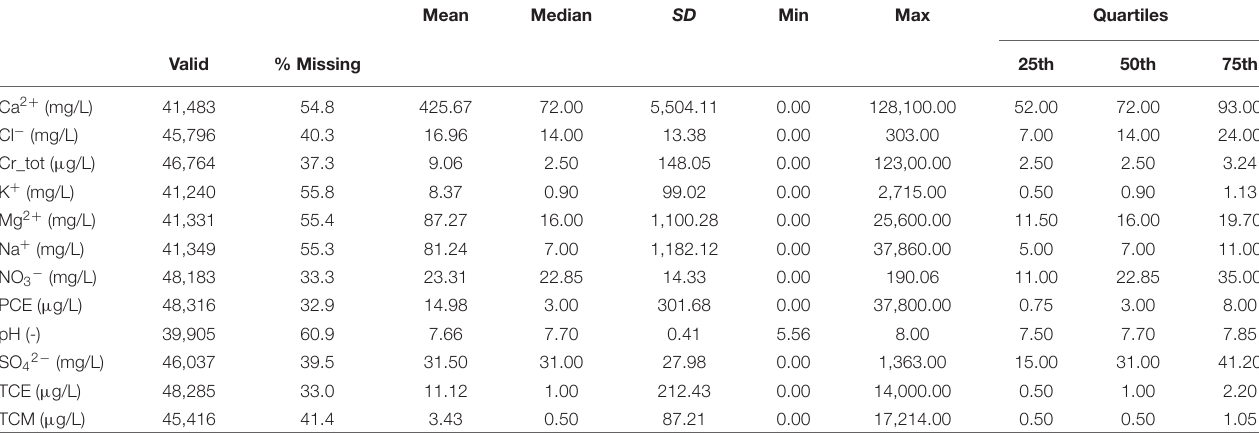
TABLE 1 | Summary statistics of the water quality parameters considered in the analysis. Mean Median SD Min Max